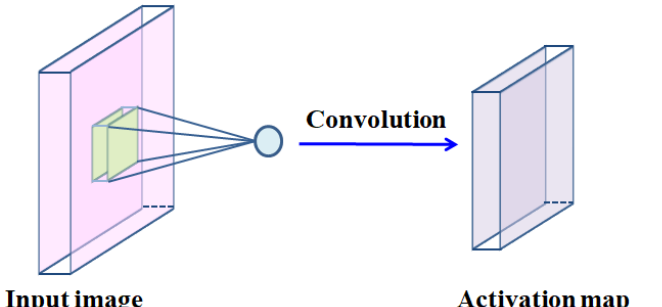
J. Mar. Sci. Eng. 2023 , 11 , x FOR PEER REVIEW Figure 3. Convolutional layer. Figure 3. Convolutional layer.